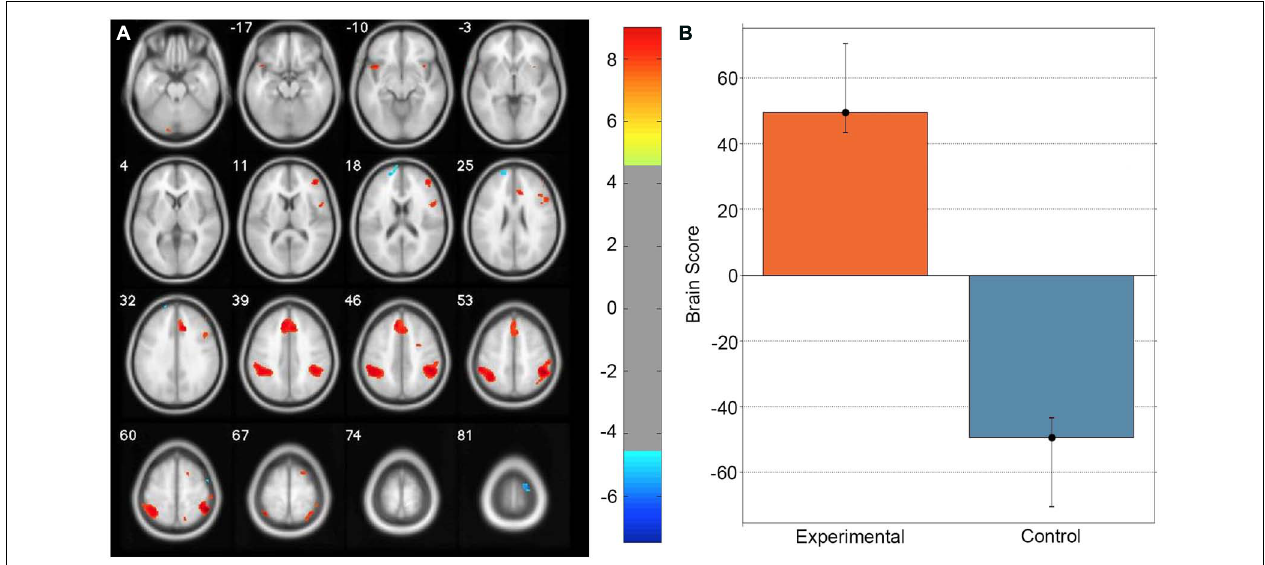
FIGURE 2 | Singular image for the LV ( p < 0.0001) from the task PLS differentiating path integration and optic flow trials. (A) Red and yellow regions represent stable increases in BOLD activity across the entire group of participants during path integration trials; blue regions represent stable increases in BOLD activity during control trials.These regions suggest top-down control systems were engaged during experimental trials, which